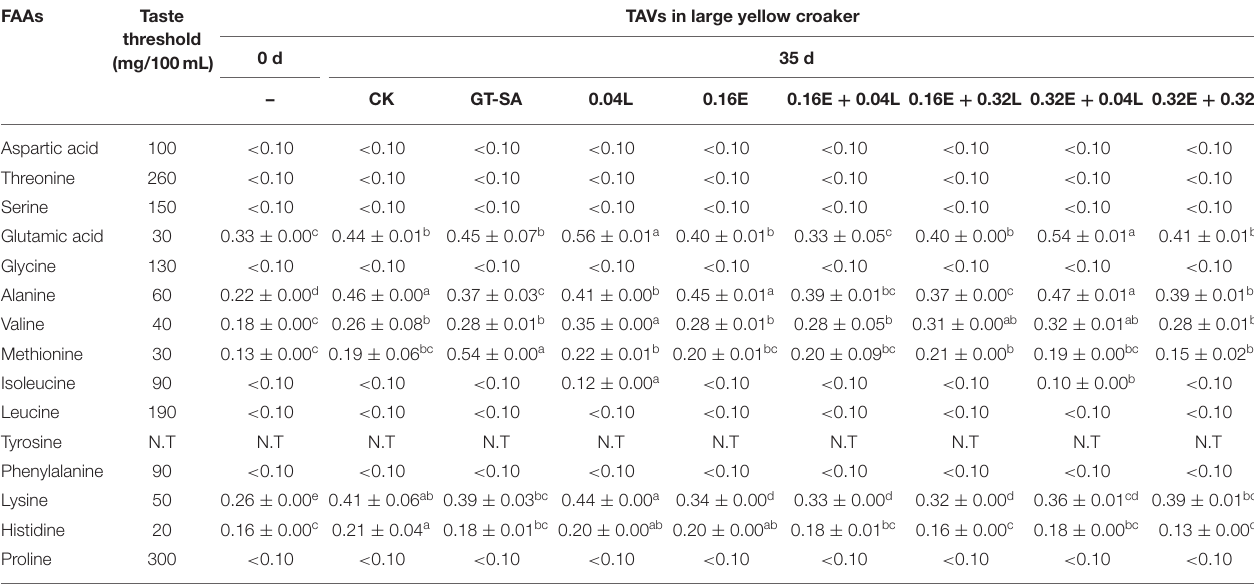
TABLE 4 | Changes in taste activity values (TAVs) of large yellow croaker samples during superchilling storage.